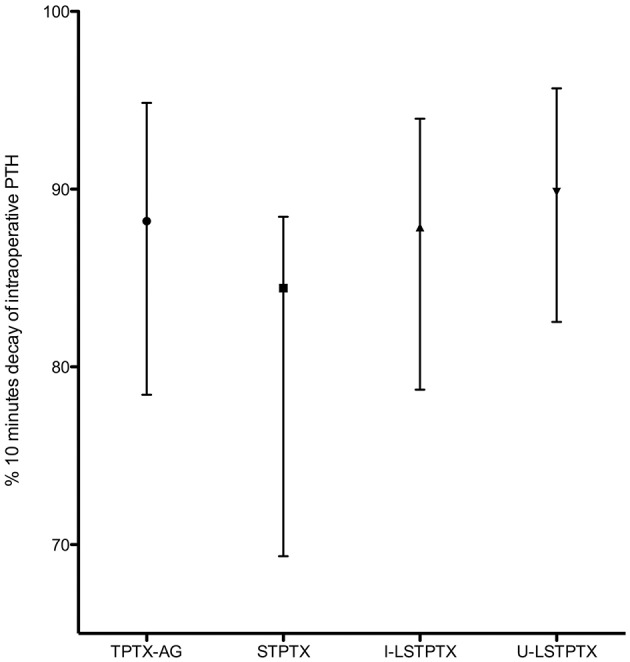
Median and interquartile range of the intensity of intraoperative PTH decay at 10 min.